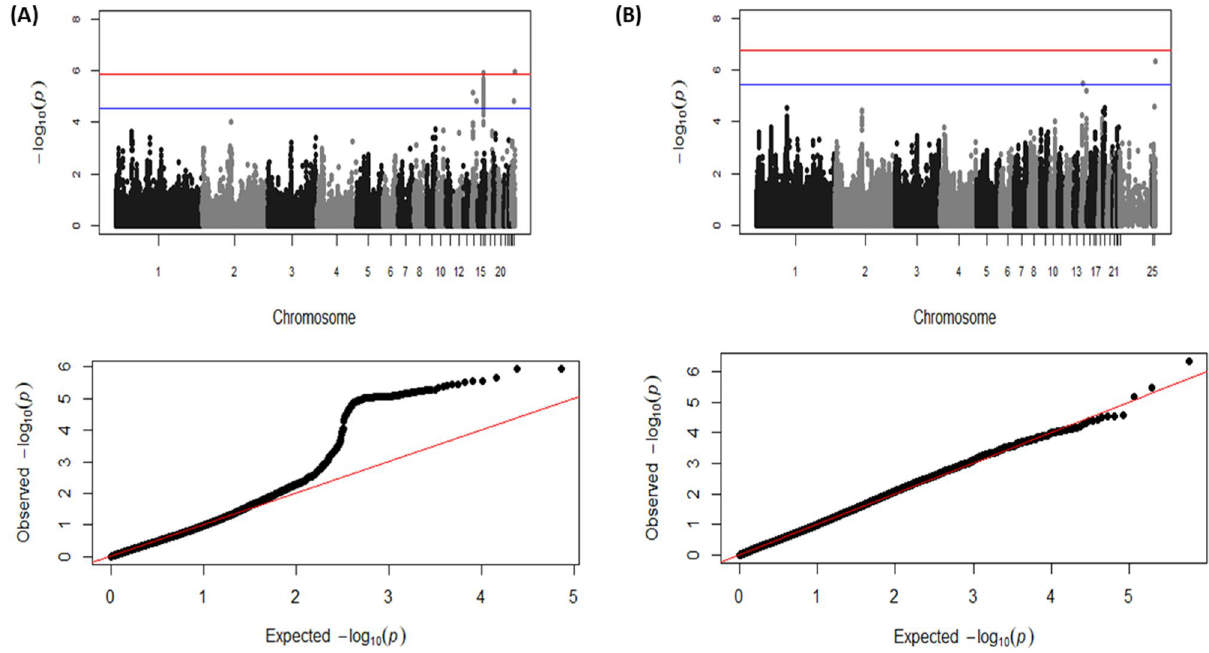
Figure 1. Manhattan plots and Q–Q plots displaying the GWAS results for chicken Campylobacter colonisation resistance using the 50K ( A ) and the imputed 600K ( B ) HD arrays. (i) Genomic location is plotted against – log 10 (P) in the Manhattan plot. Genome-wide ( P < 0.05) and suggestive genome-wide thresholds are shown as red and blue lines, respectively. (ii) Q–Q plot of observed P values against the expected P values for